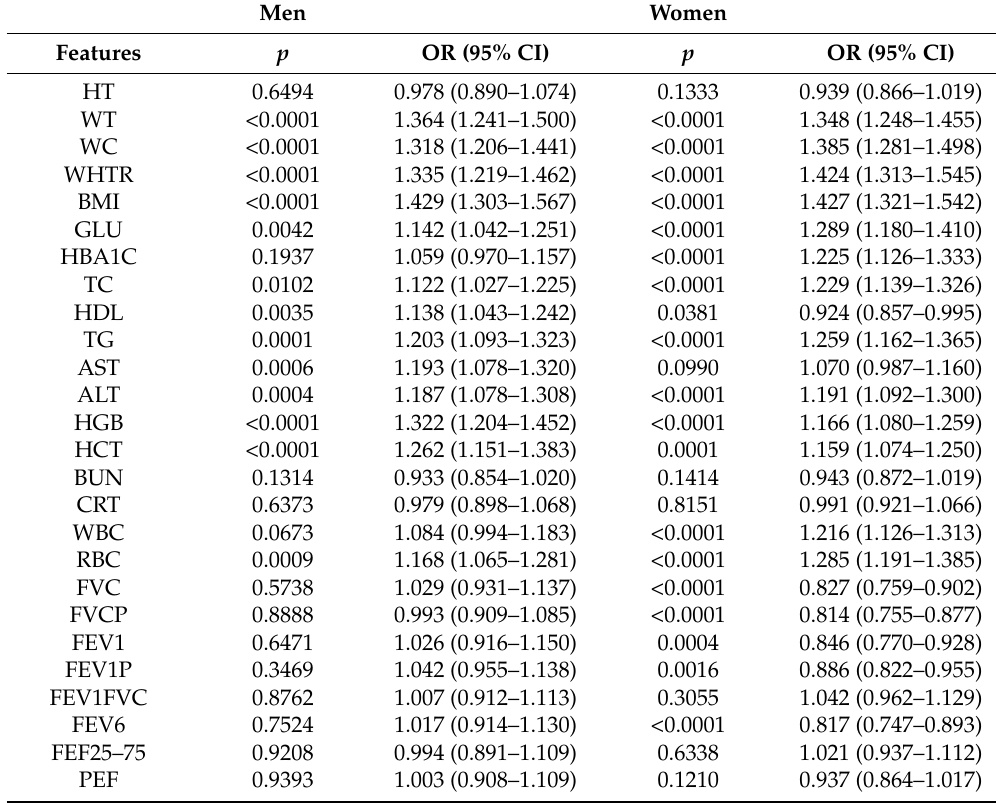
Table 2. Results of statistical analyses of differences between normotension and prehypertension in men and